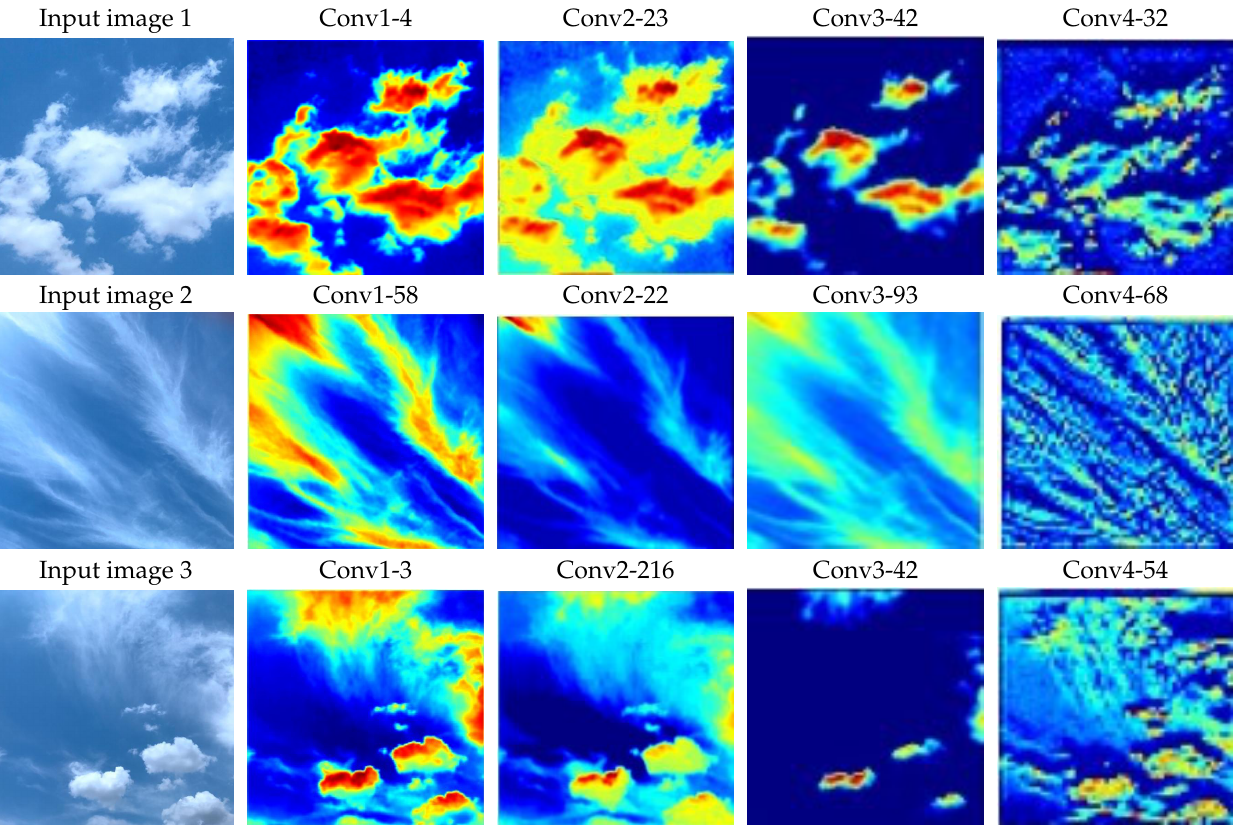
Figure 8. Visualization of feature maps from different convolution